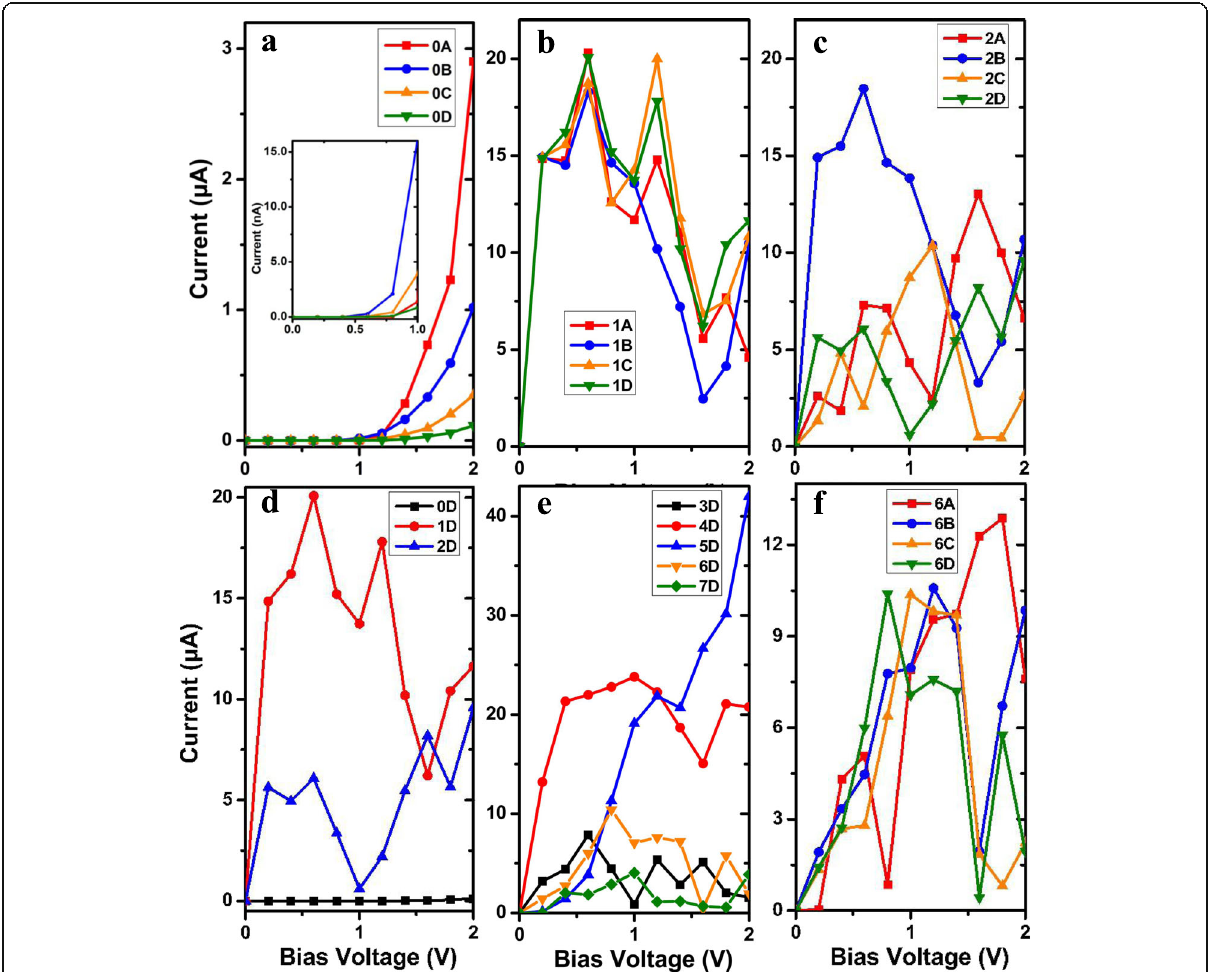
Fig. 4 (Color online) The current-voltage ( I-V ) characteristics of A γ GYNRs ( a ) without N-doping or with single N-doping as shown in b M 1 and c M 2 for the four different molecular chains as A – D. The I-V curve of A γ GYNRs with the four periodic molecular chain as D for d M 0D – M 2D or e M 3D – M 7D . f The I-V curve of A γ GYNRs for the four different molecular chains as A – D for M